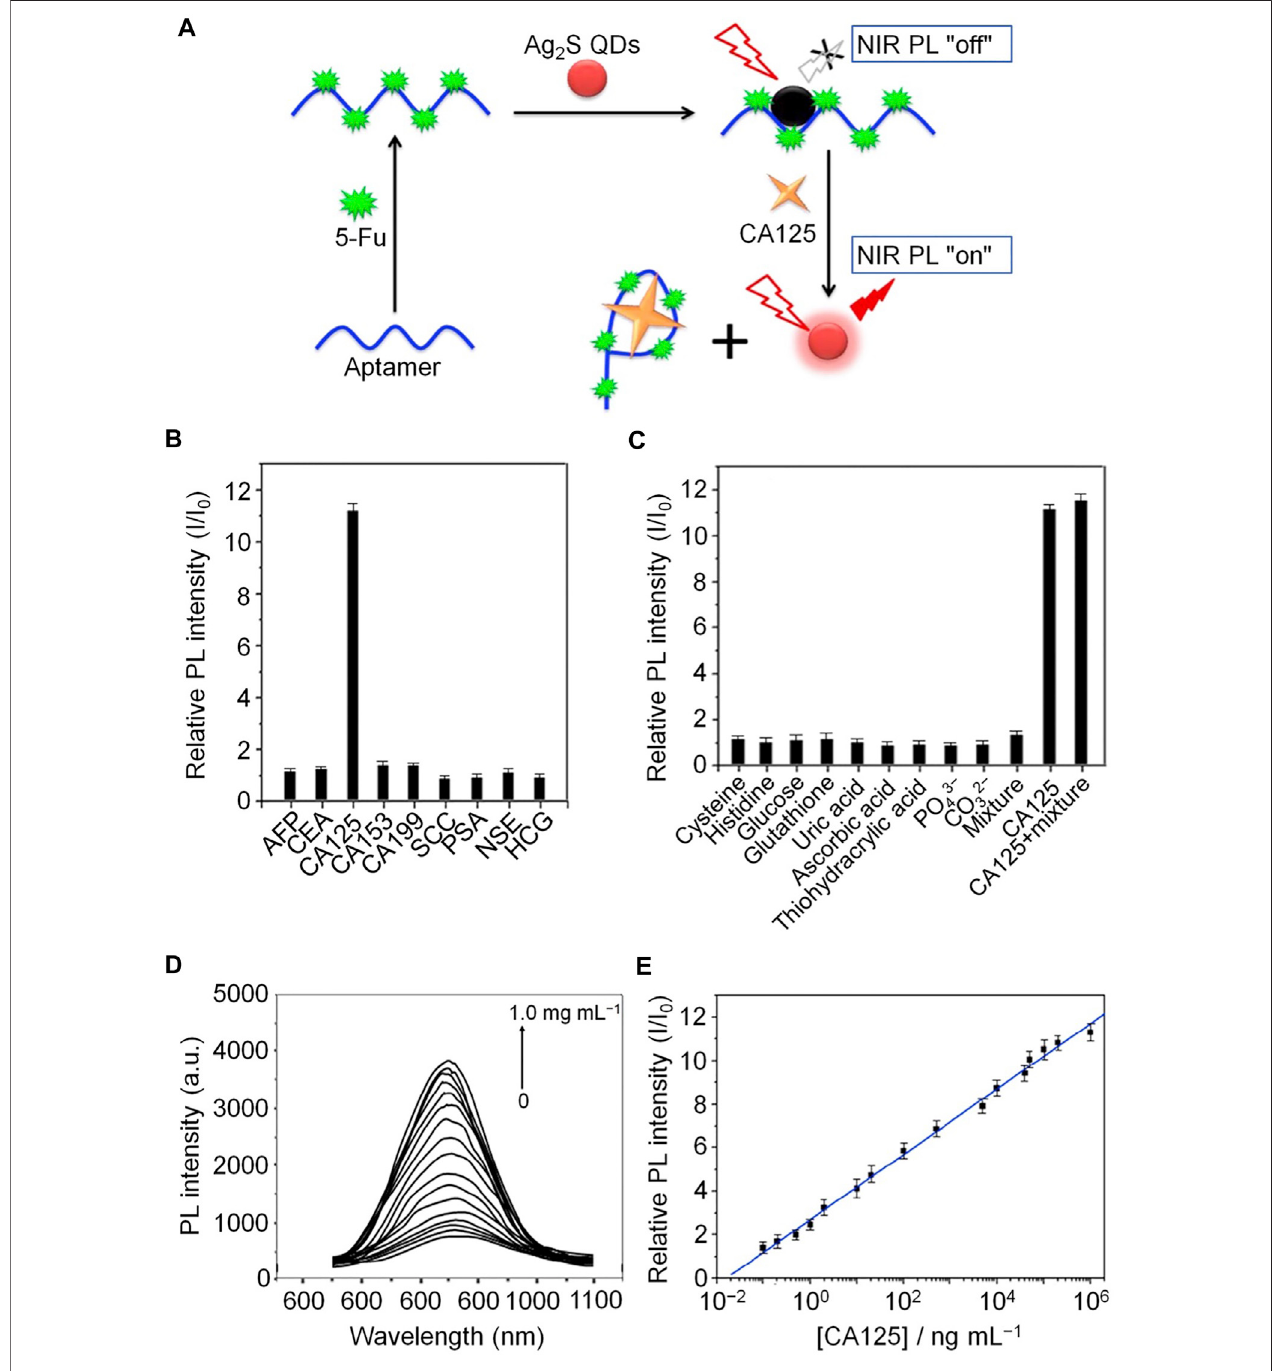
FIGURE5 | Schematic illustration ofNIR PL turn-on probe detection ofCA125. (A) Fabrication processes ofthe CA125 NIR PL turn-on probe. (B) Relative NIR PL intensities(I/I0)ofAg 2 SQDs/aptamer/5-Fuhybridsinthepresenceoftumorbiomarkersinhumanbody fl uids. (C) RelativeNIRPLintensities(I/I0)ofAg 2 SQDs/aptamer/ 5-Fu hybrids in the presence of potential components of human body fl uids. (D) NIR PL emission spectra at different concentrations of CA125. (E) Calibration curve of the NIR PL turn-on